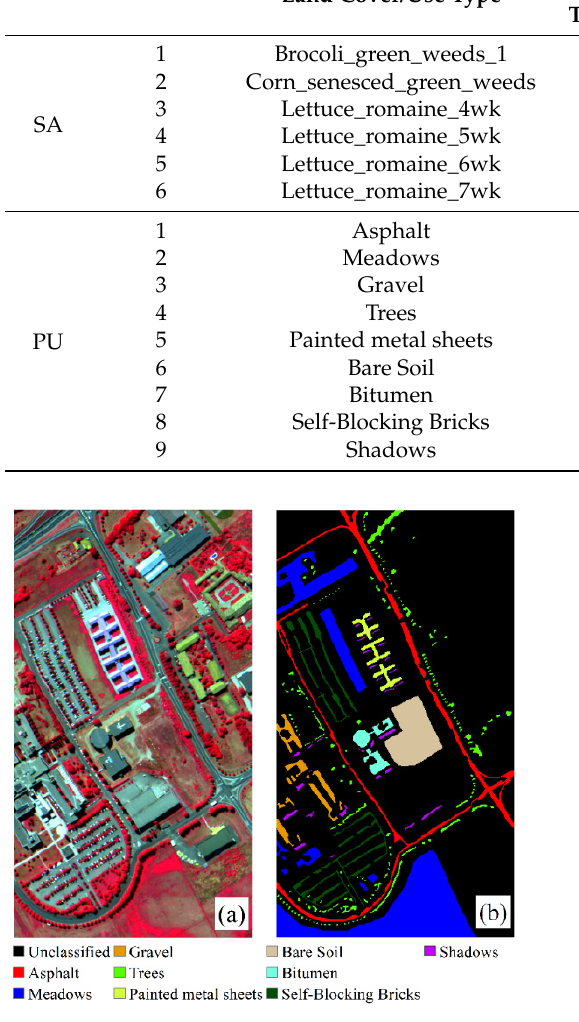
Number of Samples